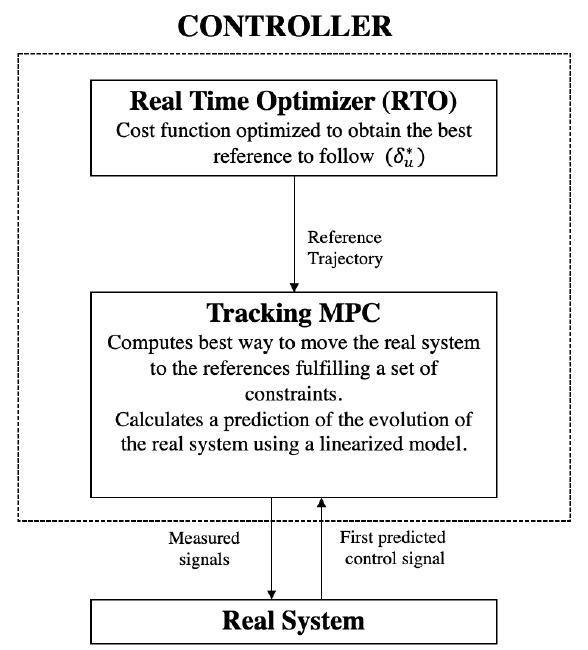
Figure 4. Flowchart of the proposed controller (RTO + MPC) and the real